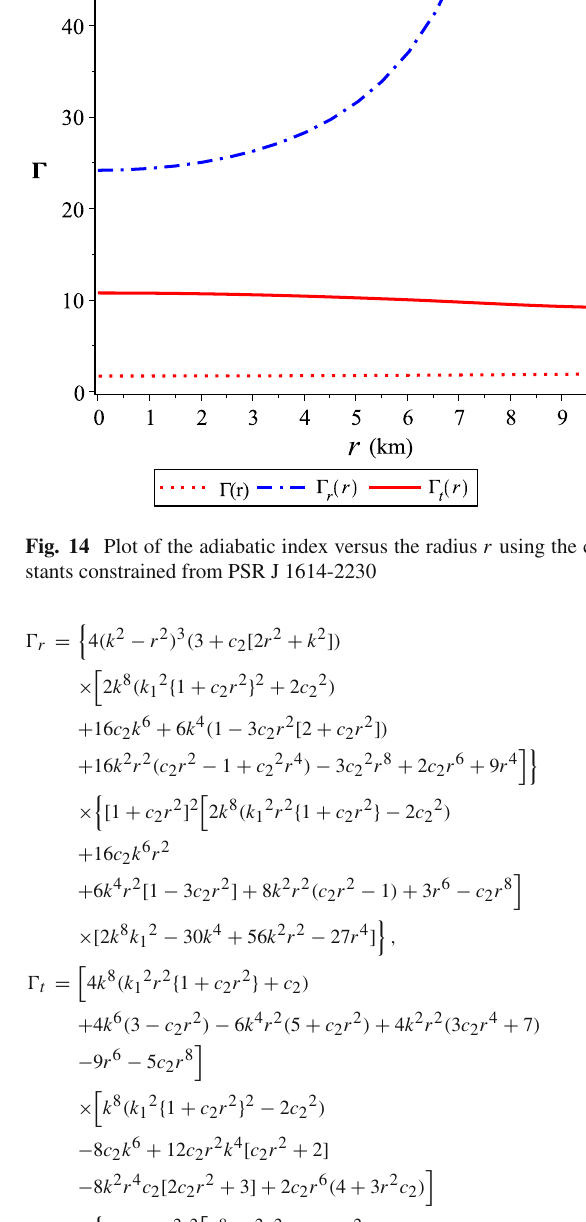
Fig. 13 Static stability of (26) against ρ r 0 . 0001 , R = 0 . 1